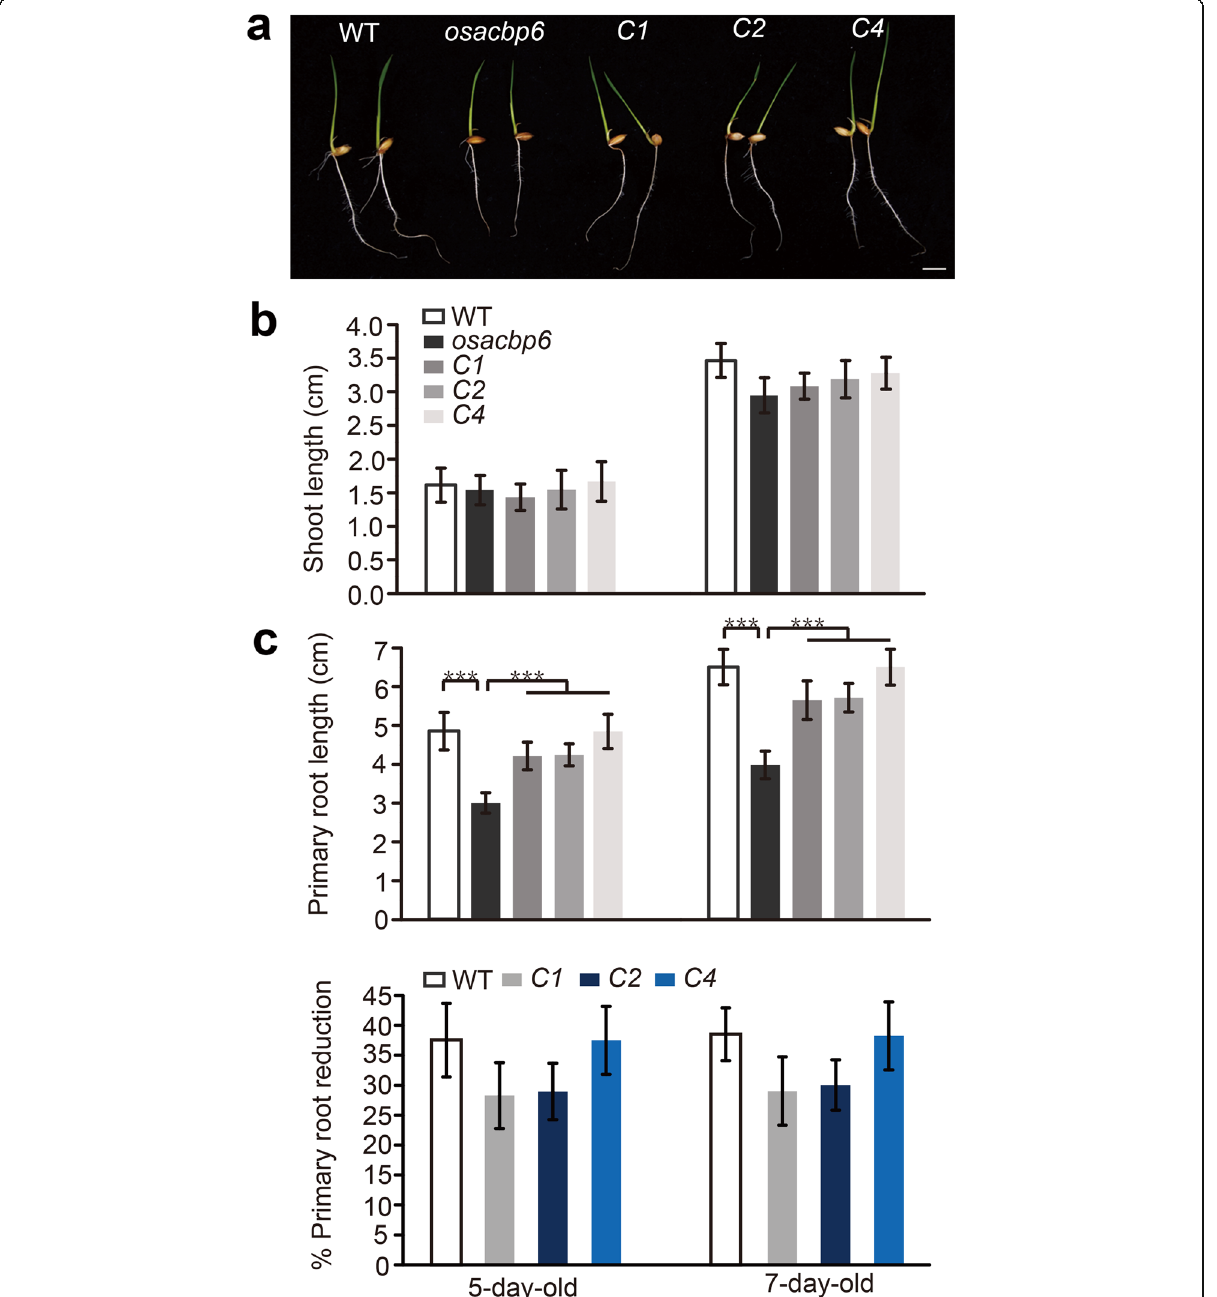
Fig. 2 Recovery in growth retardation of the rice osacbp6 mutant by complementation of OsACBP6 . a Growth of 7-day-old seedlings of wild type (WT), osacbp6 and complemented lines osacbp6 - C1 ( C1 ), osacbp6 - C2 ( C2 ) and osacbp6 - C4 ( C4 ). Bar, 1 cm. b Shoot length of WT, osacbp6 , C1 , C2 and C4 . Values are means ± SD ( n = 10). c Primary root length of WT, osacbp6 , C1 , C2 , and C4 (upper panel) and primary root reduction of osacbp6 relative to WT, C1 , C2 , and C4 (lower panel). Values are means ± SD ( n = 10). Asterisks indicate significant differences as evaluated by Student ’ s t -tests: *** P < 0.001. WT, Oryza sativa var. japonica cv.